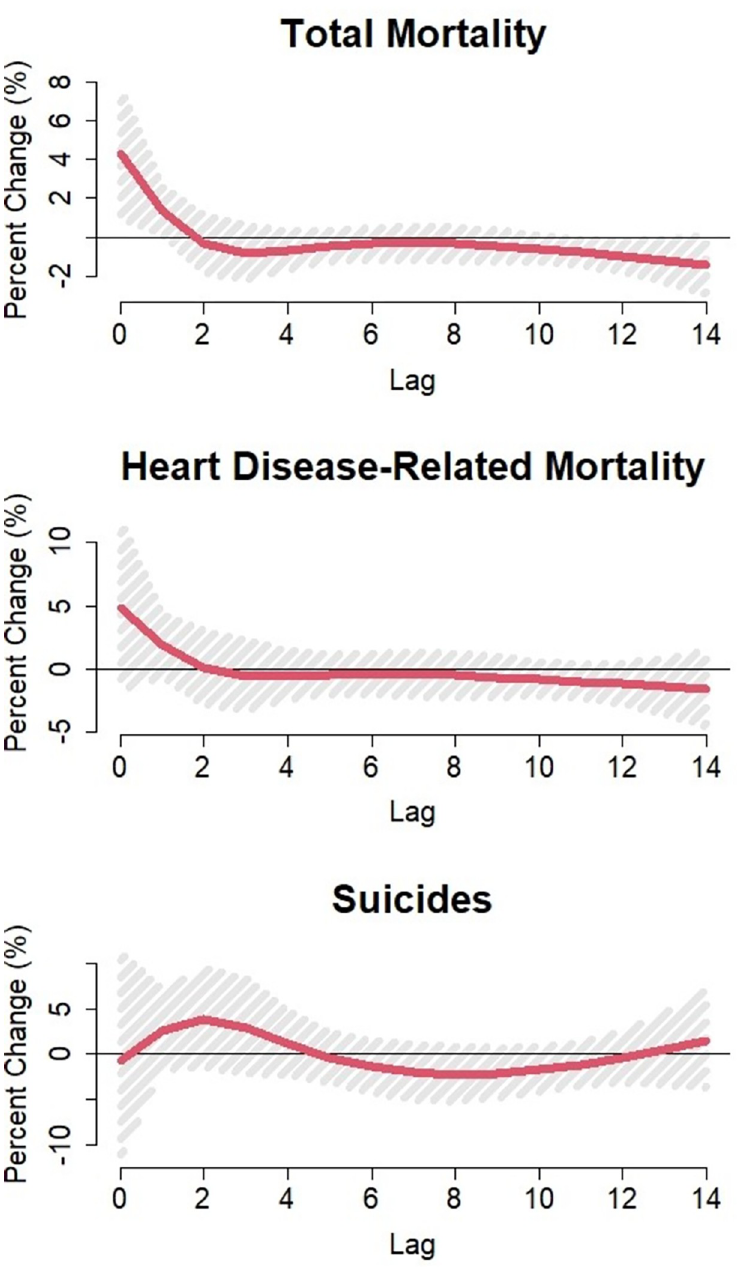
Fig 2. Lag-response curves for the percent change in suicides associated to an extreme heat day in U.S. prisons between 2001 – 2019 a . a An extreme heat day is defined as a daily maximum temperature above the 90th percentile for the respective prison